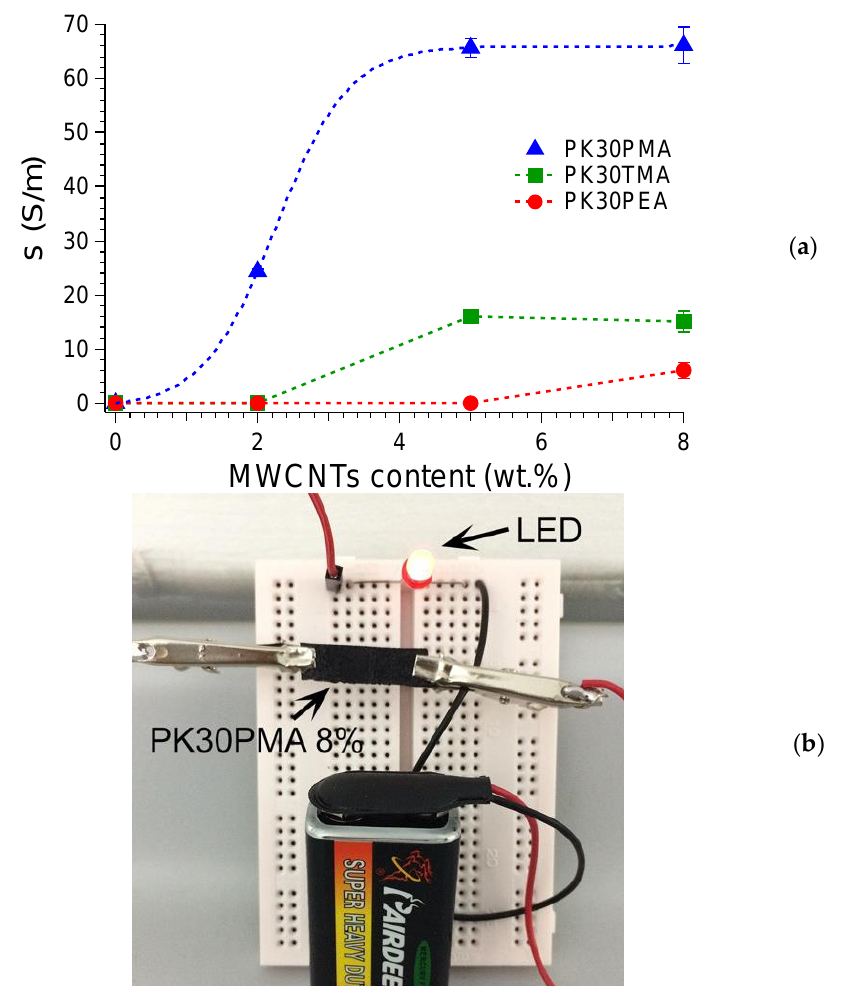
Figure 5. ( a ) Electrical conductivity of the PK30TMA, PK30PEA, and PK30PMA nanocomposites as a function of the MWCNTs loading (wt %); ( b ) photograph of the PK30PMA nanocomposite containing the 8 wt % of MWCNTs connected to an electrical circuit with a red-emitting LED.